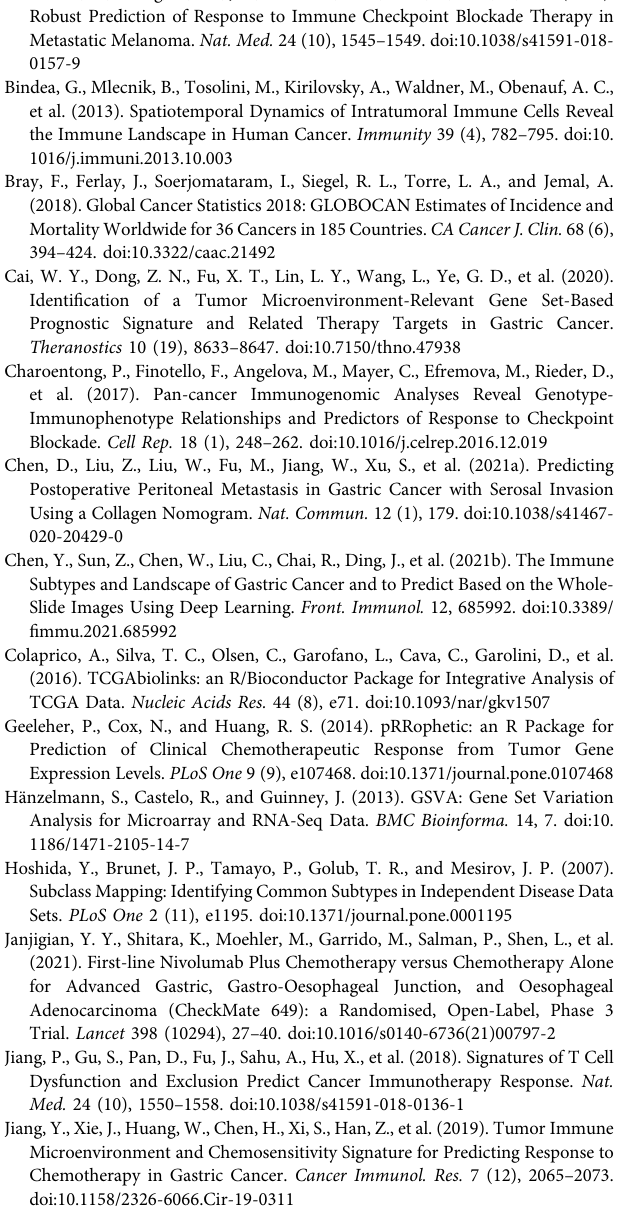
Supplementary Figure S1 | External validation of two exosome-relevant phenotypes in the GSE84437 cohort. (A) Consensus score matrix of GC specimens when k = 2. (B) CDF of consensus matrix for each k (indicated by colors). (C) Relative alterations in the area under CDF curves. (D) Tracking plot for each k. (E) PCA plot by expression pro fi ling of 15 prognostic exosome-related genes. Each point indicates each specimen, with unique colors representing exosome-relevant phenotypes. (F) Kaplan – Meier analysis of OS in two exosome- relevant phenotypes. Supplementary Figure S2 | External veri fi cation of the prognostic implication of the exosome-based gene signature for GC in the GSE15459 cohort. (A) Overview of risk score distribution (upper), survival status (middle), and